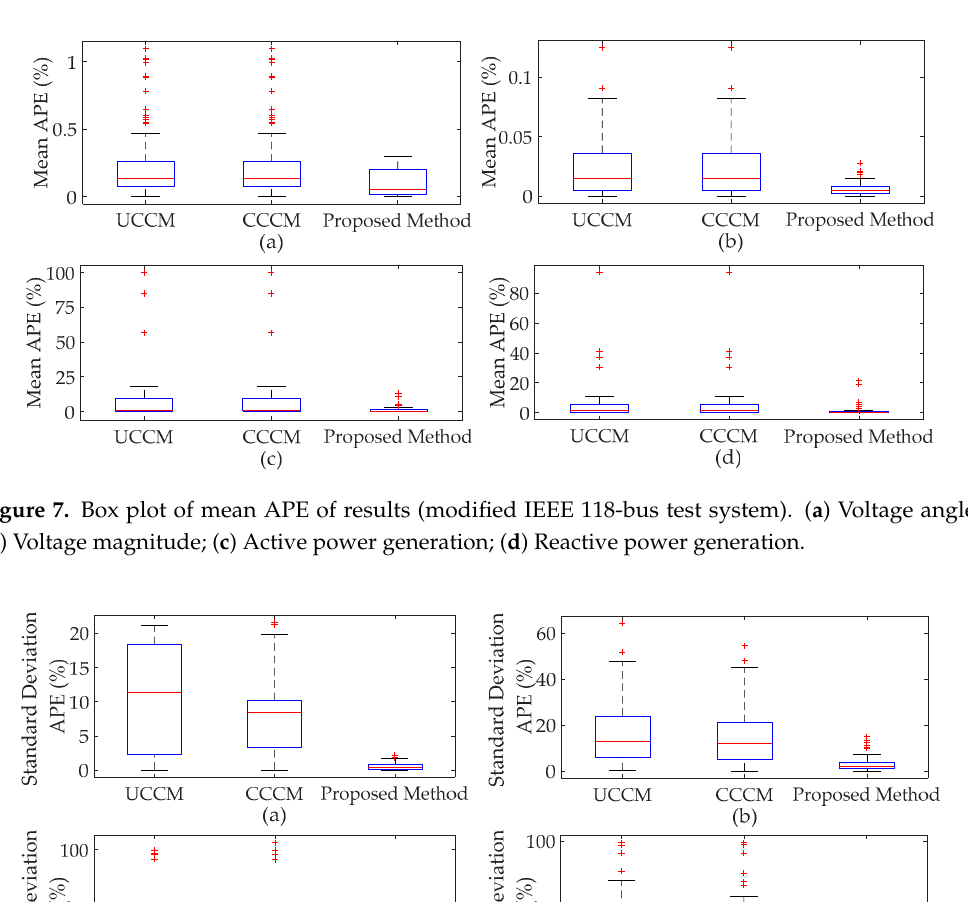
Energies 2017 , 10 , 1623 13 of 20 CCCM. The APE values of voltage angle, voltage magnitude, active power generation and reactive power generation are presented as box plots in Figures 7 and 8. It can be seen from Figures 7 and 8 that the box plots associated with the proposed method are below those associated with UCCM and CCCM, which indicates that results of the proposed method have much smaller APE values than those obtained using UCCM and CCCM. In Figure 7, for active power generation obtained using UCCM and CCCM, some mean APE values are even more than 50%. For reactive power generation obtained using UCCM and CCCM, some mean APE values exceed 20%. In Figure 8, most output variables obtained using UCCM and CCCM have large standard deviation APE values, most of which are more than 10%. These show that UCCM and CCCM are not suitable for solving the P-OPF problem with large fluctuations of stochastic variables. Figures 9 and 10 show PDFs of active power generation at bus 100 and reactive power generation at bus 4. It can be seen that the curves obtained using the proposed method are closer to the MCS histograms than those obtained using UCCM and CCCM, especially at the tails of curves. For other system variables, similar results can be obtained. Meanwhile, the computation time using the proposed method is about dozens of times less than that using MCS, as shown in Table 10. It should be pointed out that the proposed method takes more time than UCCM and CCCM. That is because the proposed method conducts P-OPF many times according to the number of clusters, and UCCM and CCCM only conduct P-OPF once. For the proposed method, the number of calculations depends on the distributions and correlations of stochastic variables, as well as the accuracy requirements (discussed in Section 4.3). The proposed method is superior in view of the fact that UCCM and CCCM cannot handle large fluctuations of input variables. In summary, the proposed method performs better, based on the accuracy, than traditional CM and requires much less computation time than MCS. Table 9. Comparison of generation cost (modified IEEE 118-bus test system).